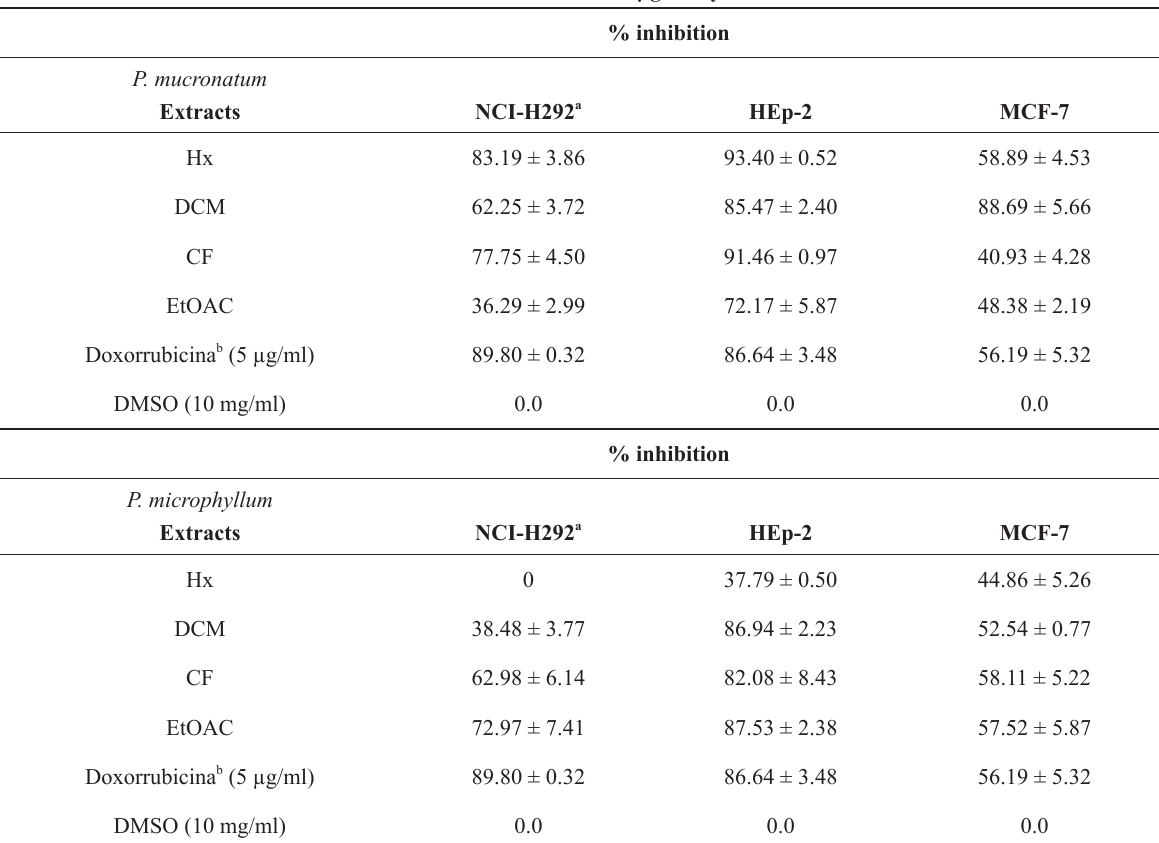
Cell growth inhibition percentage (%) of the extracts from leaves of Phoradendron microphyllum and Phoradendron mucronatum in three tumor cell lines at a concentration of 50 μg/ml by MTT method after 72 hours